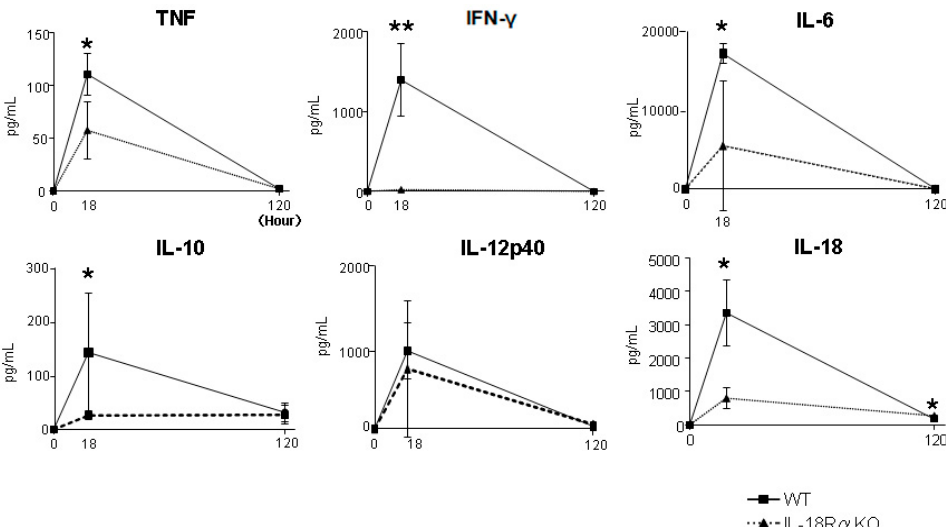
Figure 3. Effect of IL-18R α on the production of inflammatory cytokines after LPS injection. Serum TNF, IFN- γ , IL-6, IL-10, IL-12p40 and IL-18 productions were measured as biomarkers of AKI at 0 (KO and WT, n = 3), 18 ( n = 11 and n = 10) and 120 h ( n = 16 and n = 6) before and after LPS injection. The data are the mean values ± SEM (* p < 0.05, ** p < 0.01, WT vs. IL-18R α KO mice).